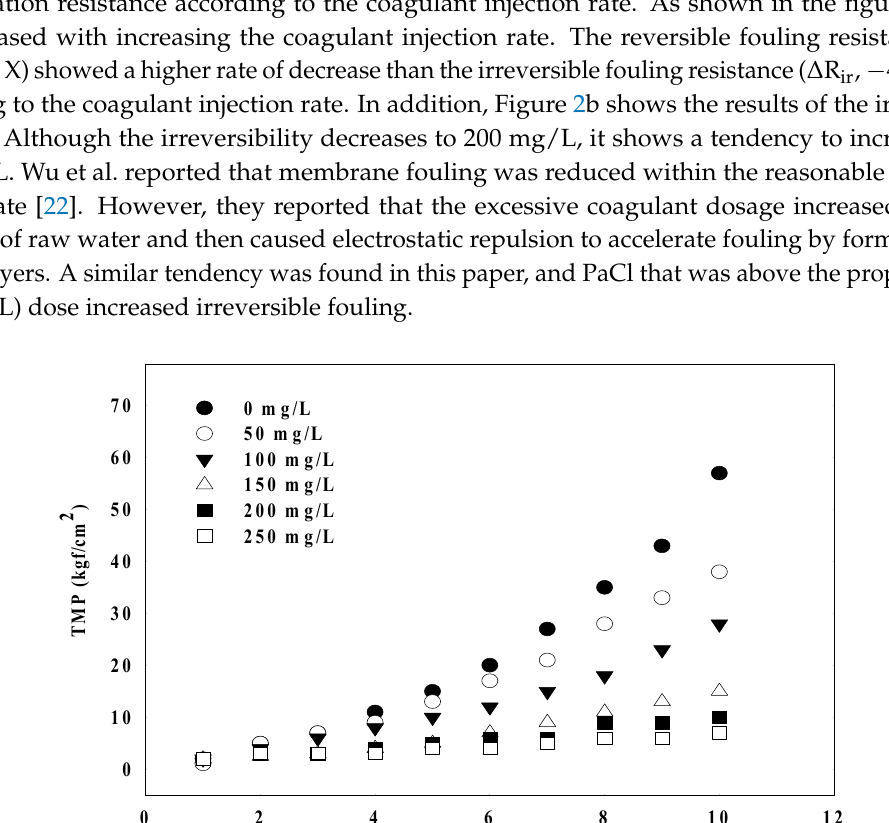
in)0 O perating tim e (m Figure 1. Comparison of changes in transmembrane pressure (TMP) according to coagulant injection.